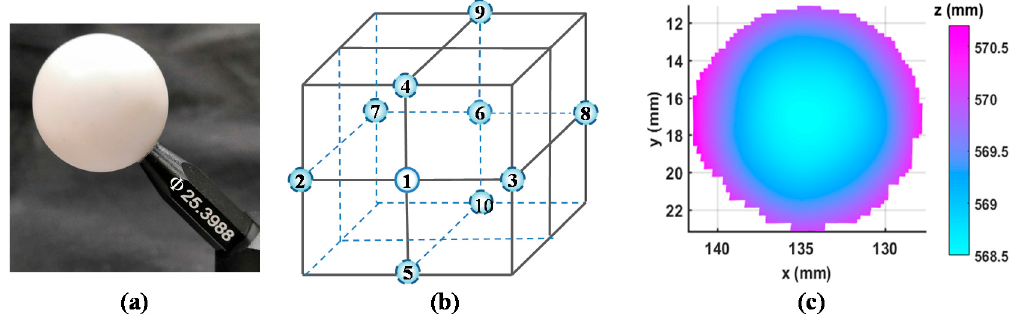
Figure 7. The measurement results of the standard ball. ( a ) The standard ball; ( b ) Ten measuring positions of the ball; ( c ) 3D reconstruction result of the ball in the first position. Table 2. The quantitative evaluation of standard ball with the diameter of 25.3988 (Unit: mm). Position Fitting Diameter Absolute Error Position Fitting